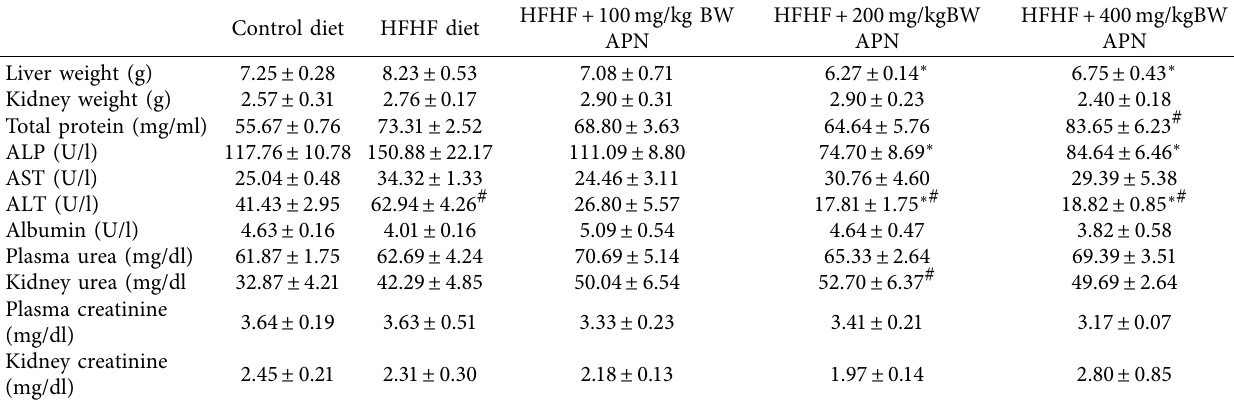
Table 4: Effect of APN on the liver and kidney function.